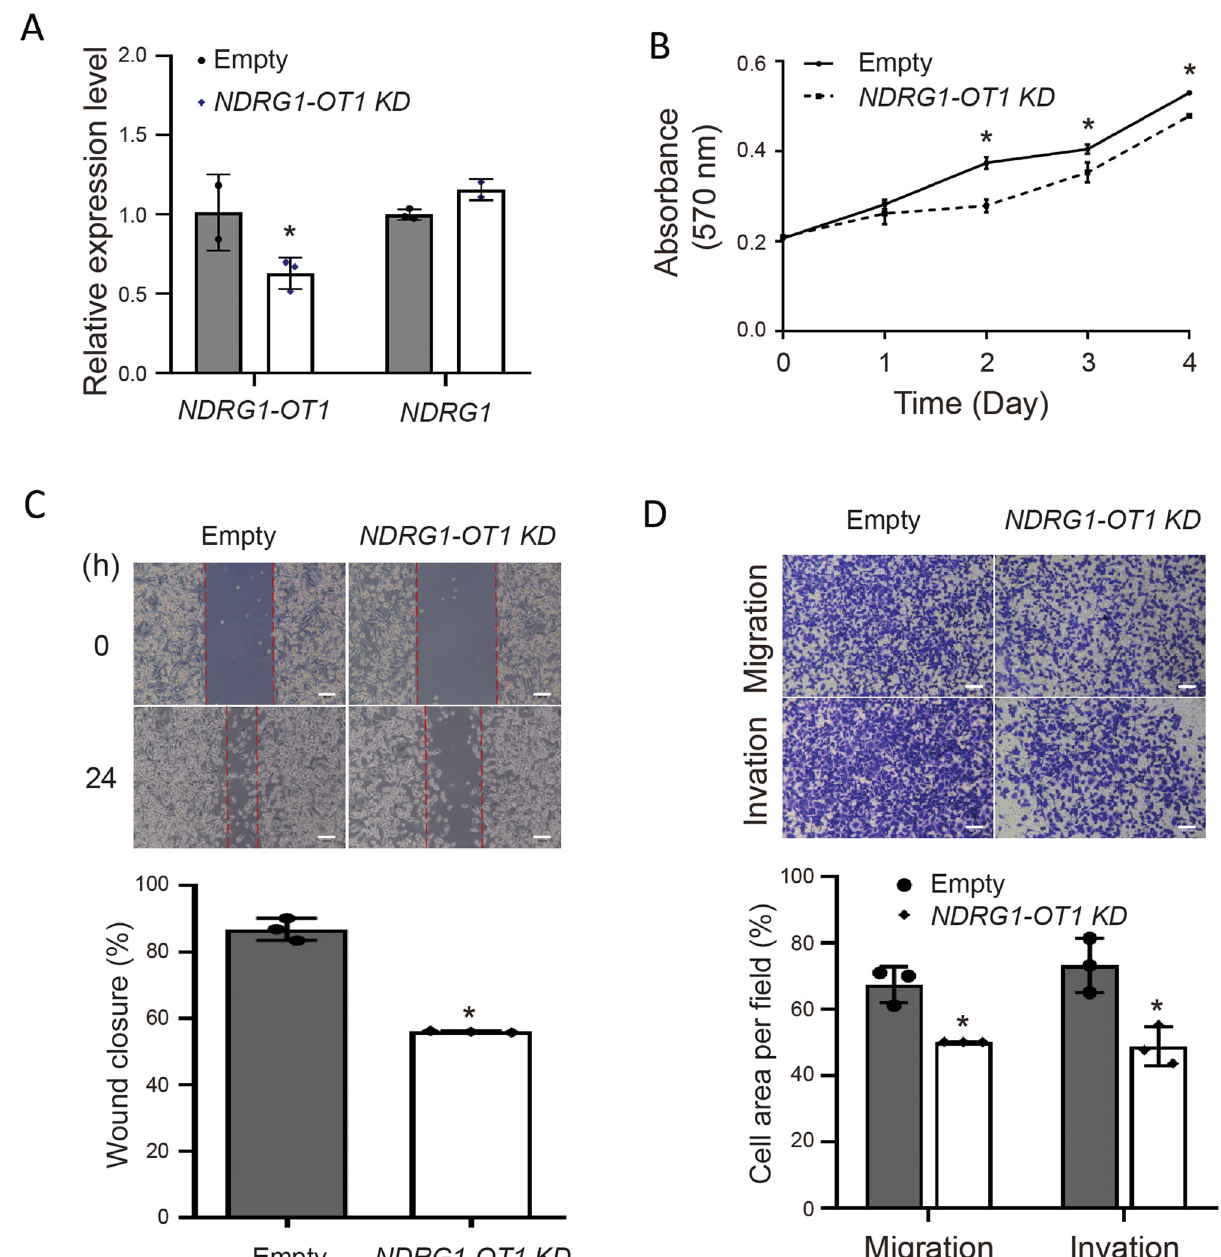
Fig. 6 Knockdown of NDRG1-OT1 inhibits tumor malignancy of triple-negative breast cancer MDA-MB-231 cells. A Relative expression levels of NDRG1-OT1 and NDRG1 in MDA-MB-231 cells after knocked down NDRG1-OT1 by Gapmer antisense oligonucleotides. B MTT assays of MDA-MB-231 cells after knockdown NDRG1-OT1 . Proliferation assays were performed by adding MTT at different time points. C Wound healing assays. Top: representative pictures taken at 0 and 24 h; bottom: quanti fi cation of wound closure at 24 h relative to 0 h. Scale bar: 0.1 mm. D Transwell migration and invasion assays. Migration ability was measured at 24 h after seeding. Invasion ability was measured at 48 h after seeding. Scale bar: 100 μ m. * P < 0.05. Cell Death and Disease (2022)